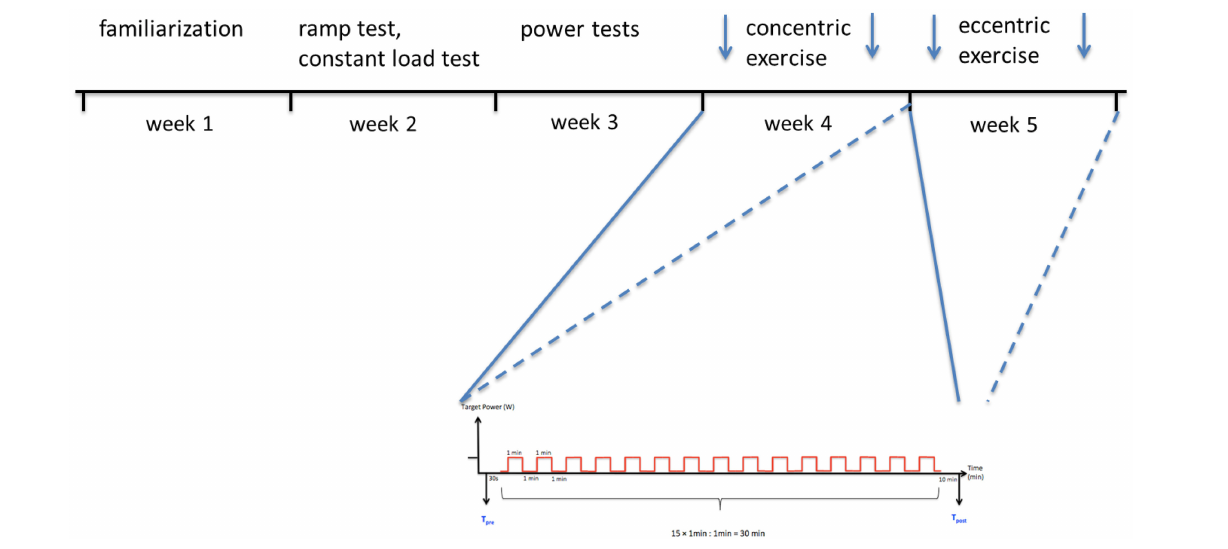
FIGURE 1 | Sketch summarizing the study protocol. Subjects conducted a number of tests over 5 weeks with ample time to allow recovery from the individual types of exercise. In the first weeks this included a familiarization to the equipment. In the second week subjects performed a ramp test (to determine maximal cardiovascular performance) and an endurance exercise at constant load (to determine the time-to-exhaustion). In the third week the subjects carried out power tests on the soft robot or force plate to determine maximal force and power of single knee extensions. In the fourth and fifth week, subjects carried out a session of interval-type concentric exercise (week 4), and eccentric exercise (week 5), on the soft robot with the same overall work output for both legs. Thereby force and blood serum measurements were made before and after the exercise sessions (arrows). Below, scheme summarizing the 15 sets of 1-min exercise, during which 30 contractions (work cycles) were performed with each leg, and the subsequent periods of